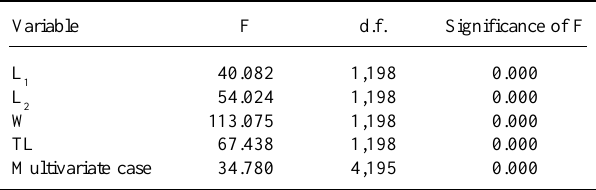
Table IV - Effect of rearing in the laboratory on the quantitative variables L , L , W and TL with the statistical values (F), degrees of freedom (d.f.) 1 2 and significance levels. Comparison of Davis 18ºC F populations (200 Drosophila subobscura females measured).